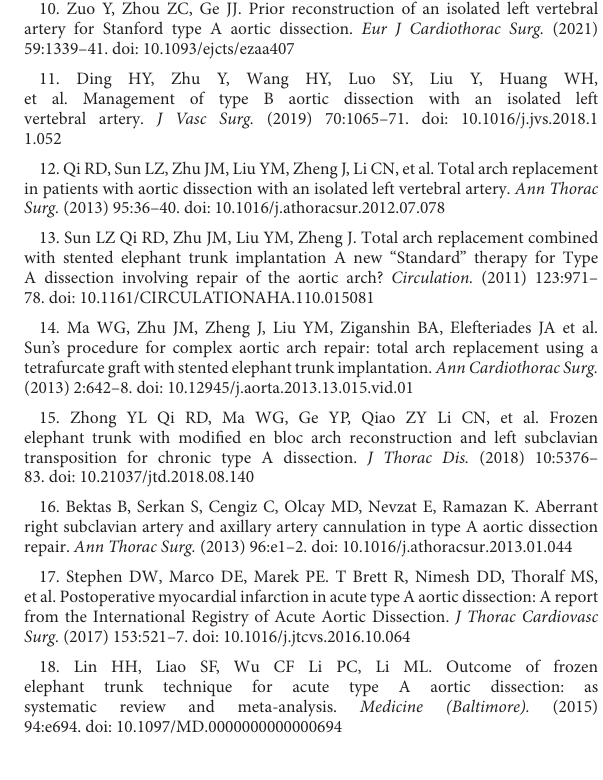
SUPPLEMENTARYFIGURES1 CT construction image after hybrid technique for ARSA. (1) Graft connecting LCCA and LSA. (2) Left common carotid artery. (3) Right common carotid artery. (4) Graft connecting RCCA and RSA. (5) Remnant of LSA. (6) Elephant trunk stent. (7) False lumen. (8) Distal aberrant right subclavian artery. SUPPLEMENTARYFIGURES2 CT images of the patient with right arch + ALSA. (A) Pre-operative CT construction image. (B) CT scan images. (C) Postoperative CT construction image. (1) ALSA; (2) LCCA; (3) RCCA; (4) False lumen; (5) Right arch; (6) Right-sided descending thoracic aorta; (7)